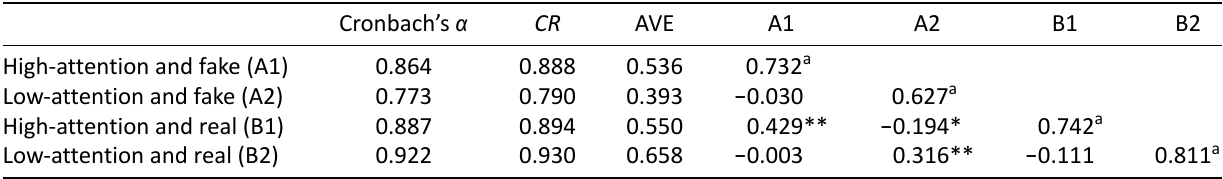
Table 3. The Cronbach’s 𝛼 composite reliabilities, AVE values, and correlations of the